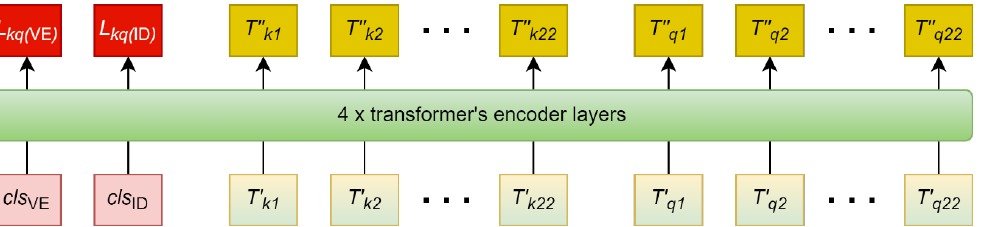
Figure 4. The ECG pair encoder is adapted from Bidirectional Encoder Representations from Transformers (BERT)’s sequence pair encoder. It extracts joint features from the two input ECG sequences. T (cid:48)(cid:48) k 1 , T (cid:48)(cid:48) k 2 , . . . , T (cid:48)(cid:48) k 22 are the final hidden states that correspond to T (cid:48) k 1 , T (cid:48) k 2 , . . . , T (cid:48) k 22 respectively; T (cid:48)(cid:48) q 1 , T (cid:48)(cid:48) q 2 , . . . , T (cid:48)(cid:48) q 22 are the final hidden states that correspond to T (cid:48) q 1 , T (cid:48) q 2 , . . . , T (cid:48) q 22